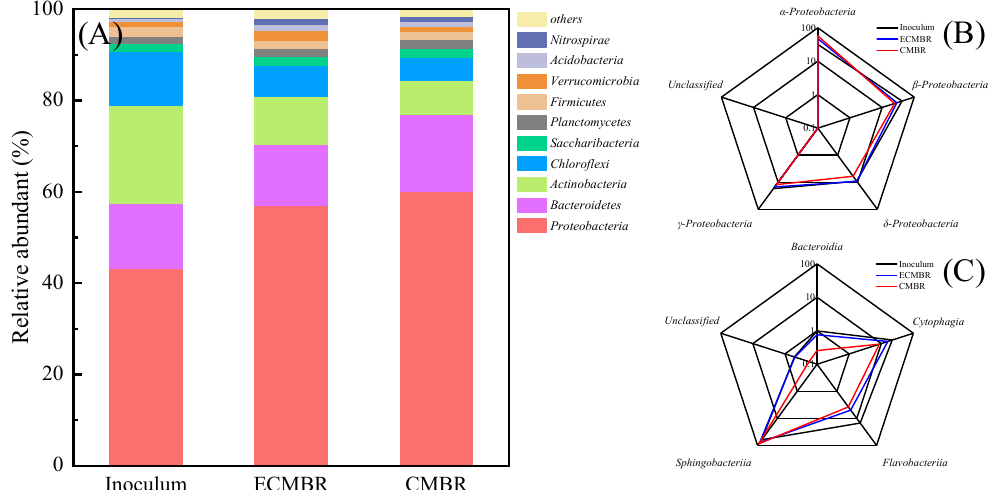
Figure 5. ( A ) Relative abundance of the bacteria of Inoculum, CMBR, and ECMBR at the phylum level. Phyla making up less than 0.1% are defined as “others”. ( B , C ) Relative abundance of the predominant phylogenetic groups of Inoculum, ECMBR, and CMBR at the class level. Relative abundance was calculated as the number of sequences affiliated that taxon divided by the total number of sequences per sample (%).